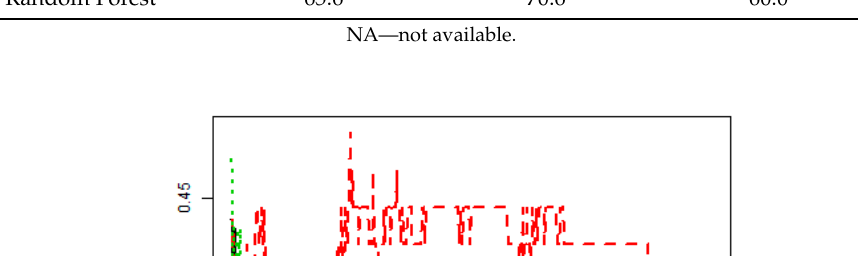
Table 4. Comparison of accuracies developed prediction models, %. Model